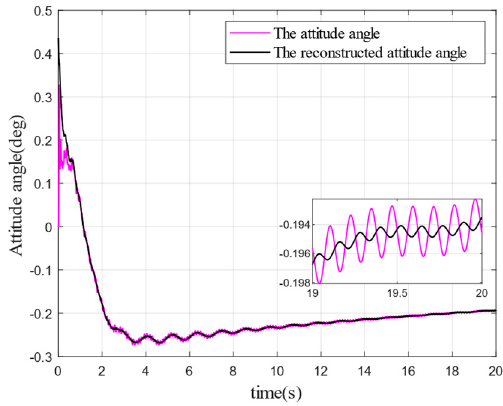
Figure 11. Attitude angle reconstruction with external interference.